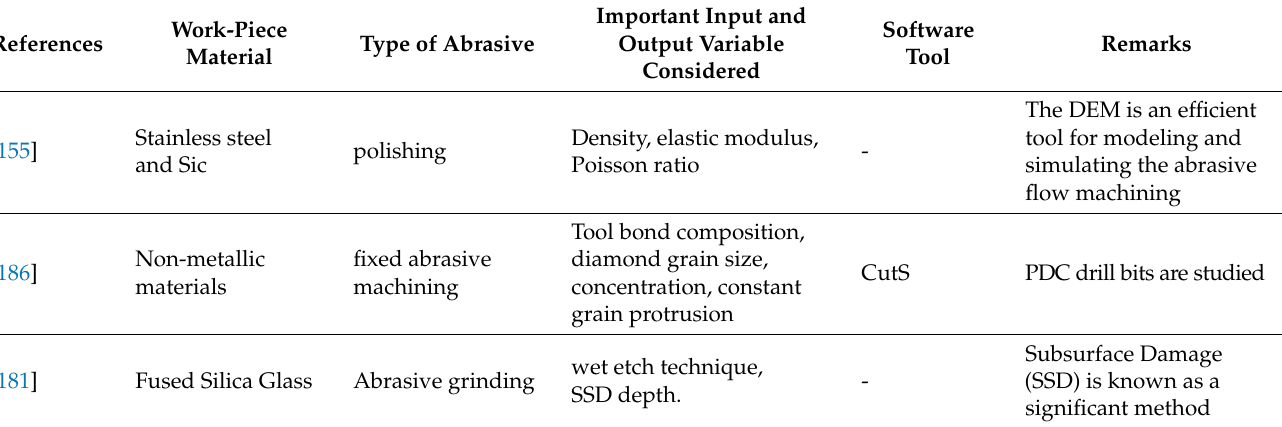
Figure 34. The erosion process of micro-hole formation on glass by the overlapping impacts. ( a ) A snapshot of the material removal process, ( b ) the snapshots of the transient impact process under different impacting times [185]. Table 8. Summary table of DEM-based modeling and simulation of the loose abrasive-based